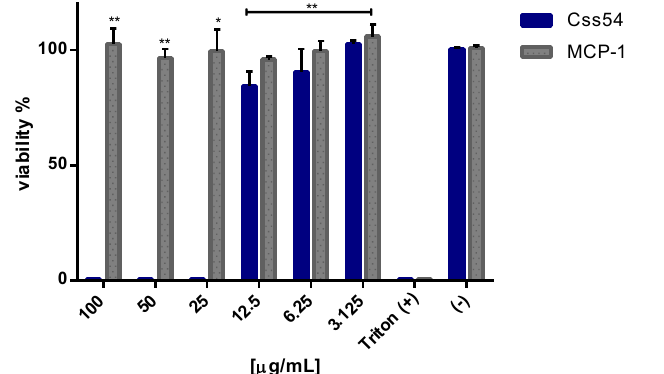
Figure 2. Css54 inhibits macrophage viability. Viability of RAW 264.7 (1 × 10 5 ) cells challenged for one hour with different concentrations of Css54 or MCP-1 was determined. Triton (+): cells treated with 1% Triton and without Css54 or MCP-1; ( − ): cells without molecule. This figure shows the average of three independent experiments, (* p < 0.05; ** p < 0.01) .